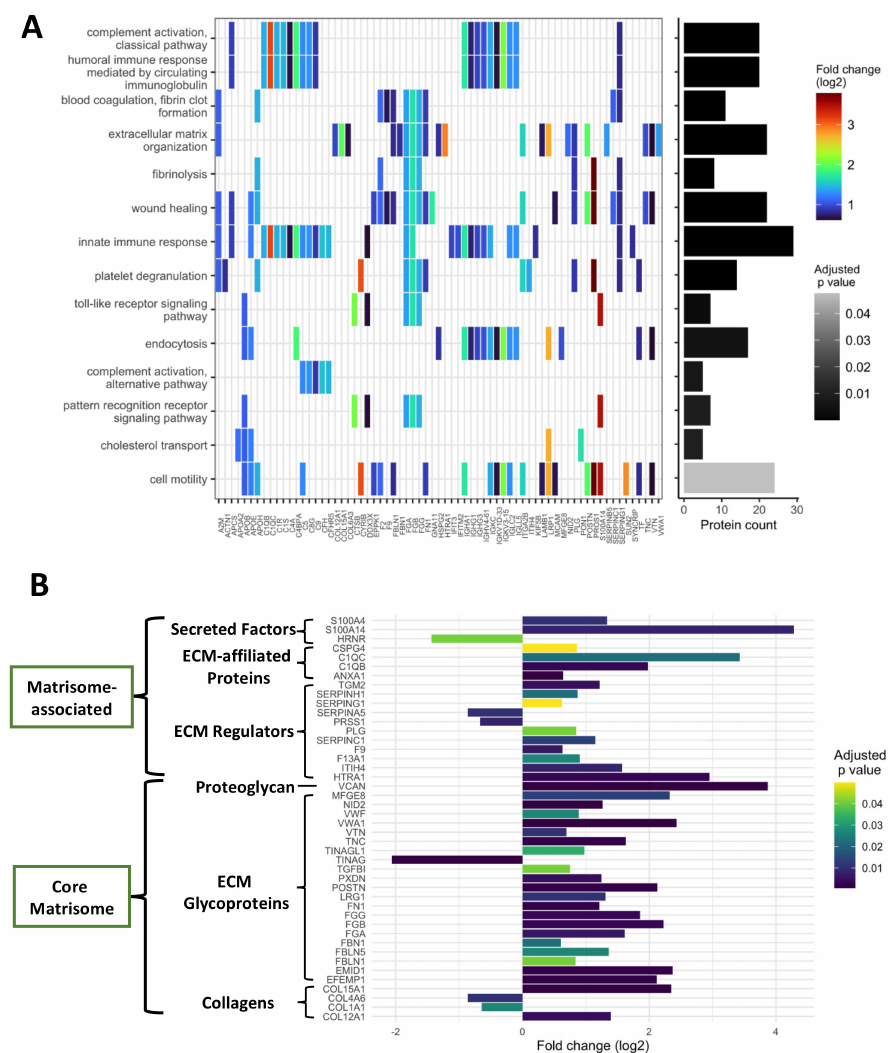
Figure 4. Characterization of the proteome of transplant glomerulopathy, with a heatmap-like plot displaying the main enriched biological processes ( A ) and a description of the extracellular matrix remodeling ( B ). ( A ) Biological processes follow the Gene Ontology terminology, identified by performing overrepresentation analyzes, using the enrichGO function of the clusterProfiler R package version 4.0.5. Only the biological processes involving overrepresented proteins of the caABMR/aABMR comparison are presented here. Fold changes (log2) are displayed with a color gradient. Number of proteins enriched in each biological process is presented as a bar plot on the right hand side. Redundant biological processes were manually removed. ( B ) Extracellular matrix proteins (ECM) differentially represented in transplant glomerulopathy. Fold changes are illustrated as a bar plot. A grey-scale gradient reflects the p -values. Each protein is annotated by its ECM category according to the Matrisome database. Abbreviations: aABMR, active antibody- mediated rejection; caABMR, chronic active antibody-mediated rejection; SG, stable graft control; ECM, extracellular